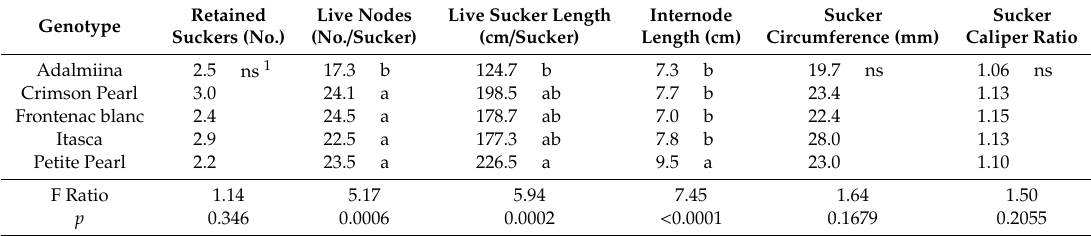
Table 3. Sucker metrics for re-established grapevine suckers of establishing genotypes trained in 2019 after winter kill during the 2018–2019 winter at the NDSU Horticulture Research Farm near Absaraka, ND, USA. Retained Live Nodes Genotype Suckers (No.) (No. /